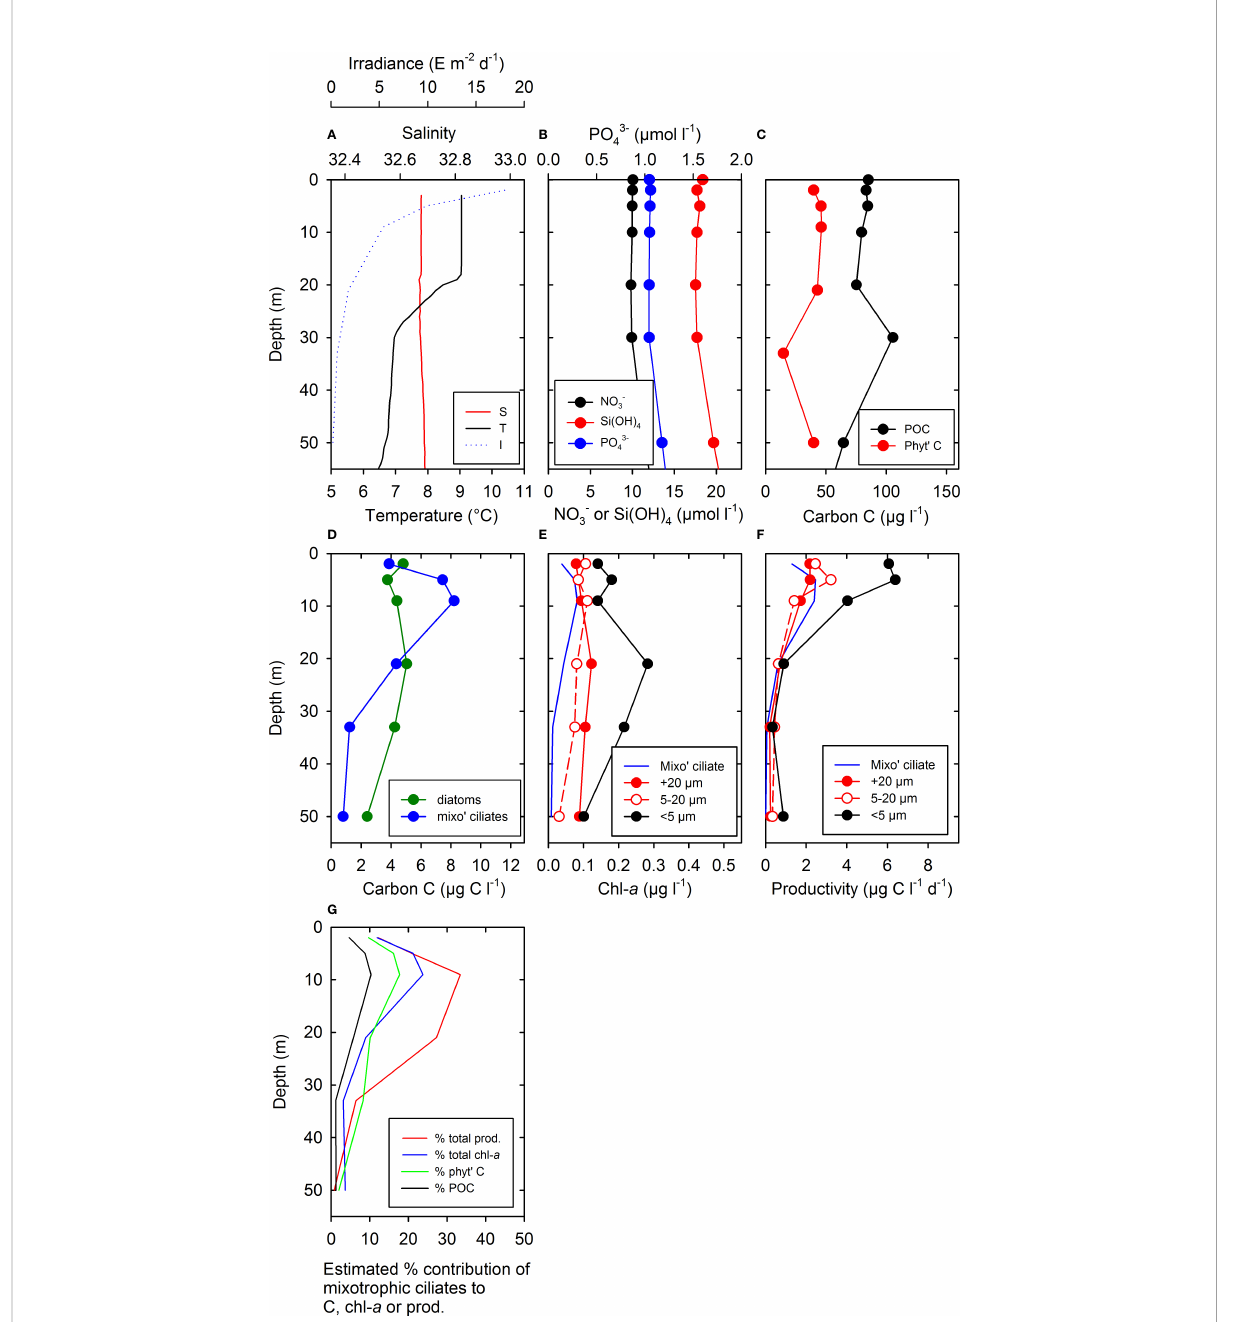
FIGURE 4 Depth pro fi les of oceanographic properties and biological measurements in the upper water column at OSP in June 1998. Abbreviations are given in Table 1B. (A) T, S, and total daily irradiance, I. (B) Concentrations of NO 3- , Si(OH) 4 , and PO 43- . (C) POC and phyto C (D) total cellular carbon from diatoms (diatom C) and mixotrophic ciliates (mixo ciliates, mixo C) estimated from microscopy, (E) estimated range of total chl- a content of mixo ciliates (calculated using C pro fi les shown in (D) , and the mid-range of C:chl- a ratios of 100 for mixo ciliates given by Putt, 1990). Also shown in (E) are size-fractionated chl- a measurements (<5 µm, 5 – 20 µm, and >20 µm) taken on the same day. (F) Range of PP rates estimated for mixo ciliates using the chl- a pro fi le estimated in (E) , combined with the P vs. I relationship given for mixo ciliates (Putt, 1990) and our I pro fi le (shown in A ) collected on the same day. Values assumed were P max = 2.1 pg C pg chl- a − 1 h − 1 and a = 0.03 pg C pg chl- a − 1 h − 1 [µmol photons m − 2 s − 1 ] − 1 representing mean values for mixo ciliates (Putt, 1990, see Methods for details). Also shown in (F) are size-fractionated 14 C PP measurements (<5 µm, 5 – 20 µm, and >20 µm) taken on the same day. (G) Estimated % contribution of mixo ciliates to total PP >0.2 µm (sum of fractions shown in F ), total chl- a content (sum of fractions shown in E ), phyto C (shown in C ), and total POC (shown in C ). Estimated % contributions of mixo ciliates to total chl- a and total PP assumed a C:chl- a ratio of 100 as in (E)